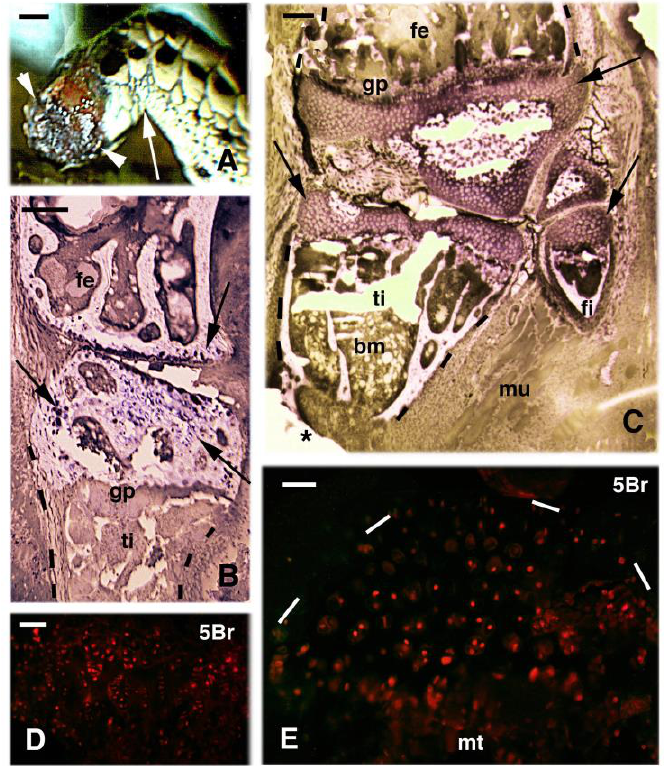
Figure 3. Images of amputated hindlimb ( A ), histological sections of the knee bones in the stump ( B , C ), and 5BrdU labeling (5Br, 4 hours post-injection) of regenerated cartilaginous epiphyses at about 30 days post-amputation ( D , E ) in P. muralis . ( A ) hindlimb stump (arrowheads indicate the stump surface) at 6 days post-amputation (the arrow indicate the knee). Bar, 1 mm; ( B ) histological detail on the knee with untouched epiphyses, at 11 days post-amputation of the distal part of the limb. Arrows indicate that most cells of the cartilage have lost the extracellular, basophilic stain. Methyl-blue and Eosin stain. Bar, 100 µ m; ( C ) knee bones of amputated hindlimb (the asterisks indicate the plane of cut) after about 25 days from the amputation. Large masses of cartilaginous tissues (arrows) are present in the epiphyses of femur (top), tibia and the smaller fibula (bottom). Bar, 50 µ m; ( D ) detail on the 5BrdU-labeled cells (5Br) present in the growth plate located in a non-injured epiphysis at about 25 days post-amputation of the distal part of the femur. Bar, 20 µ m; ( E ) 5BrdU-labeled cells in the cartilaginous epiphysis of an untouched femur at about 25 days post-amputation of the distal part of the limb. Bar, 20 µ m. Legends: bm, bone marrow; fe, femur; gp, growth (metaphyseal) plate; mu, muscles; mt, metaphyseal (growth) plate; ti, tibia; The dashes outline the bone shape. In other experiments, after the damage of the epiphyses in the lizard P. muralis , by producing small cuts in the articular cartilage or in the diaphyses, the formation of irregular holes and cartilage degeneration occurs [34,36]. However, at 14, 21, 28 and 32 days post-injury, a variable amount of new